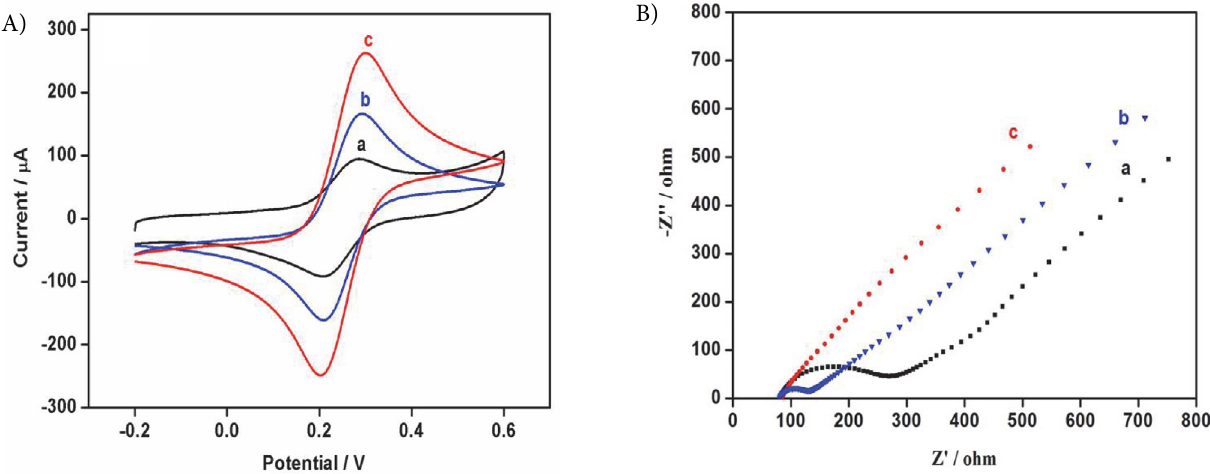
Fig 3. Cyclic voltammograms (A) and electrochemical impedance spectroscopy (B) of 5.0 mM [Fe(CN) 6 ] 3–/4– on bare GCE (a), PEDOT/CNCC/GCE (b), PEDOT/Fe 3 O 4 -CNCC/GCE (c) in 0.1 M KCl solution. The scan rate is 100 mV s –1